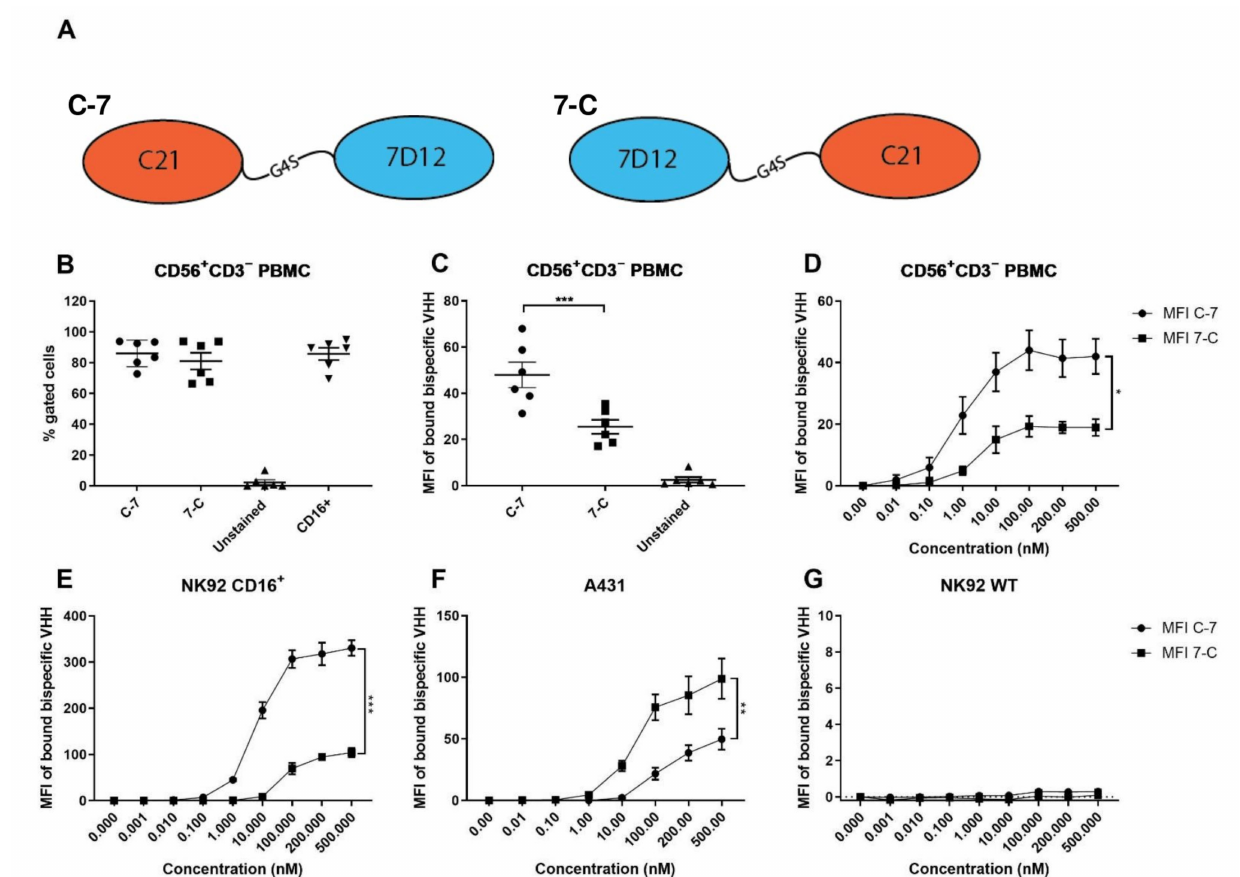
Figure 1. Binding characteristics of C-7 and 7-C bispecific VHHs to CD16 and EGFR. ( A ) Graphical representation of the bispecific VHHs. ( B ) Percentage of bispecific VHH + cells (at 100 nM) and CD16 + cells among CD56 + CD3 − cells in PBMC, n = 6. ( C ) Median Fluorescence Intensity (MFI) of bound bispecific VHH on CD56 + CD3 − cells in PBMC at 100 nM, n = 6. ( D ) MFI of bound bispecific VHH on CD56 + CD3 − cells in PBMC n = 3. ( E ) MFI of bound bispecific VHH to CD16 + NK92 n = 3. ( F ) MFI of bound bispecific VHH to A431 (EGFR ++ ) n = 8; ( G ) MFI of bound bispecific VHH to CD16 − EGFR − NK92 WT, n = 3. The data are presented as mean ± SEM. Significance is presented as p < 0.05 *, <0.01 **, <0.001 ***. p -values were determined by two-tailed paired t -test ( B , C ) or two-way ANOVA ( D , G ). Abbreviations: PBMC = peripheral blood mononuclear cells, C-7 = C21-7D12 bispecific VHH, 7-C = 7D12-C21 bispecific